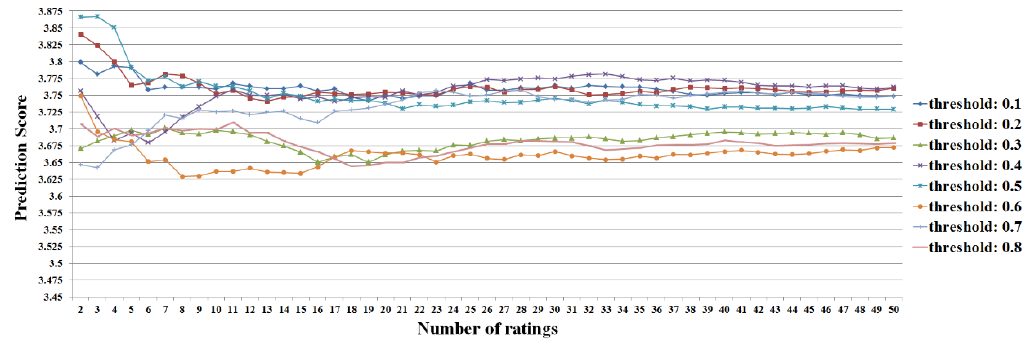
Figure 5. Results of the prediction score based on the cosine similarity in the user-based filtering.